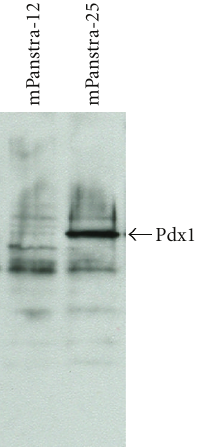
Figure 5: Pdx1 expression in SACK-D mPanstra pancreatic stem cell strains. Immunoblot analyses were performed with whole cell lysates (100 μ g protein each) from the indicated mPanstra stem cell strains grown in their maintenance medium. The arrow indicates the 45 kDa Pdx1 protein detected with specific